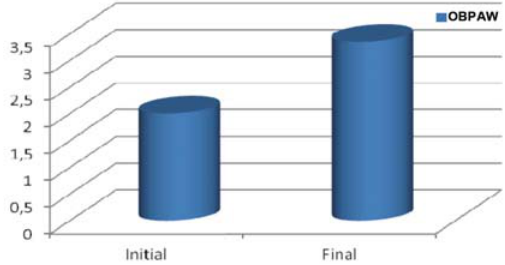
FIGURE 1. Comparison between the overall initial and fi nal assessments of body posture (Wolonski method). OBPAW, Overall Body Posture Assessment by Wolanski